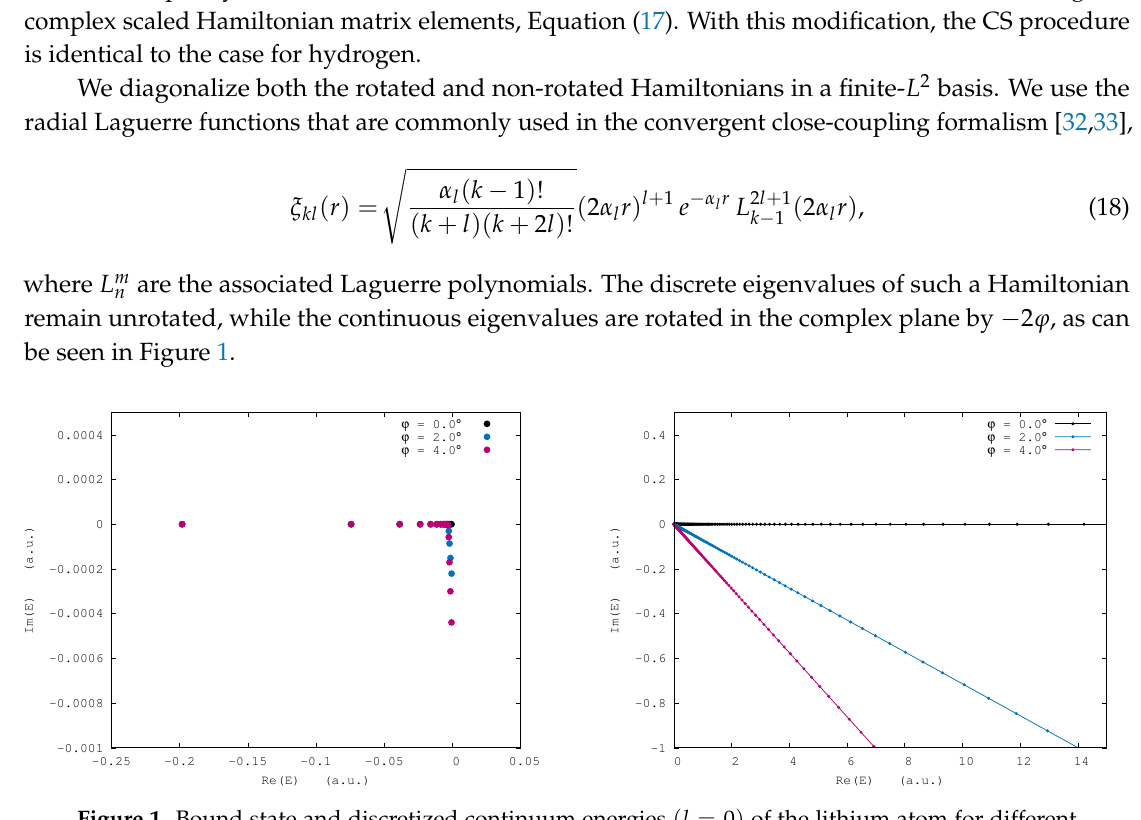
Figure 1. Bound state and discretized continuum energies ( l = 0 ) of the lithium atom for different rotation angles. Bound state energies that have a non-zero imaginary component are pseudostates, the larger the imaginary component of the energy the further the bound pseudostate is from an